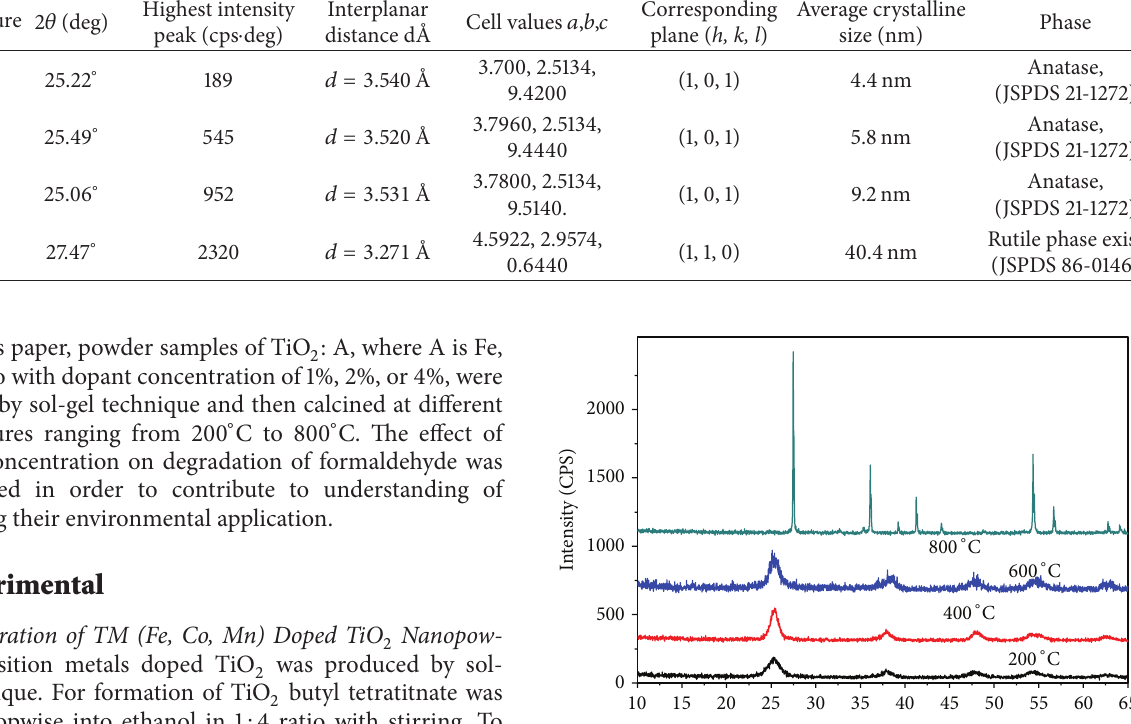
Table 1: XRD data for 1% TM doped TiO